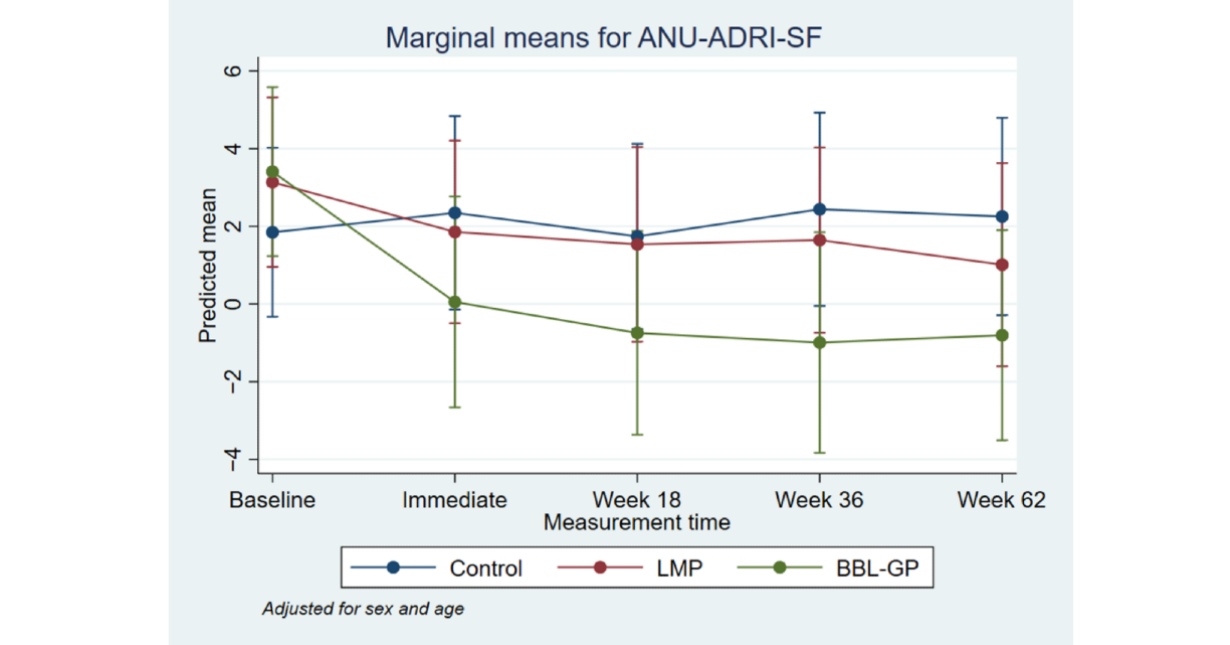
Figure 2. Mean Australian National University Alzheimer Disease Risk Index Short Form with 95% CI, by time point and intervention group. ANU-ADRI-SF: Australian National University Alzheimer Disease Risk Index Short Form; BBL-GP: Body Brain Life in General Practice; LMP: Lifestyle Modification Program.